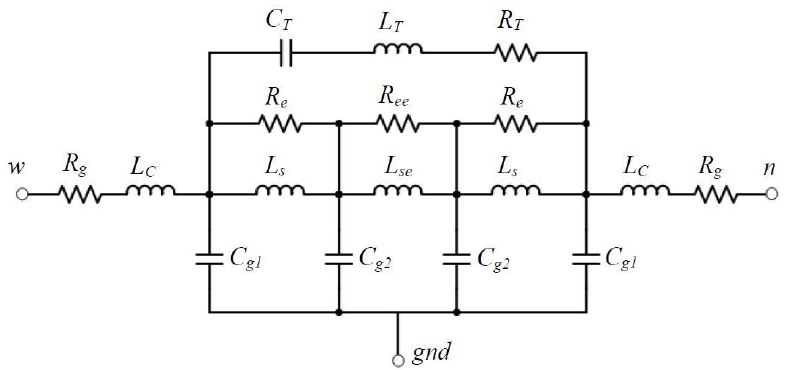
Figure 18. HF phase circuit proposed in